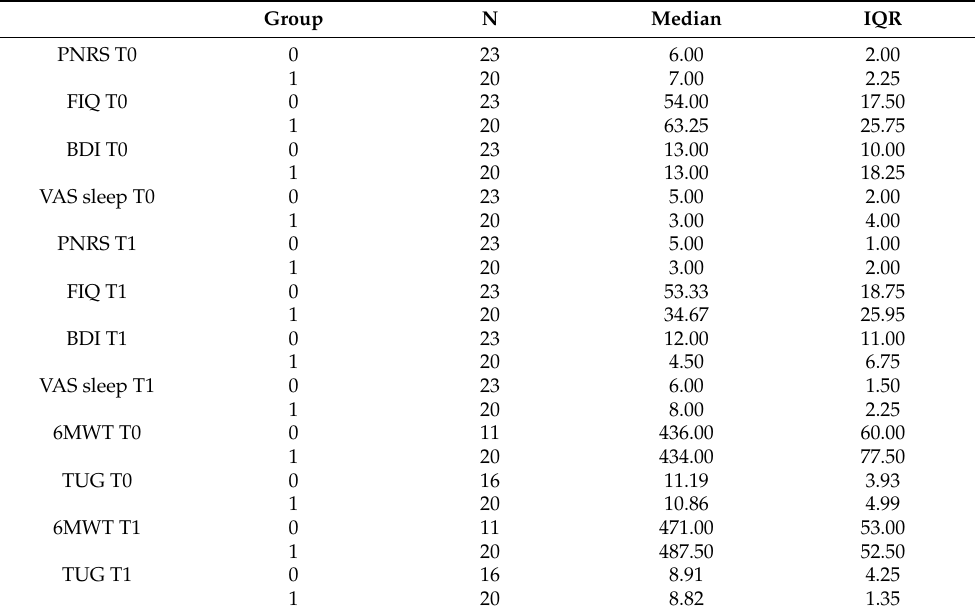
Table 2. Median and interquartile range (IQR) of self-reported and performance-based clinical variables at T0 and T1.